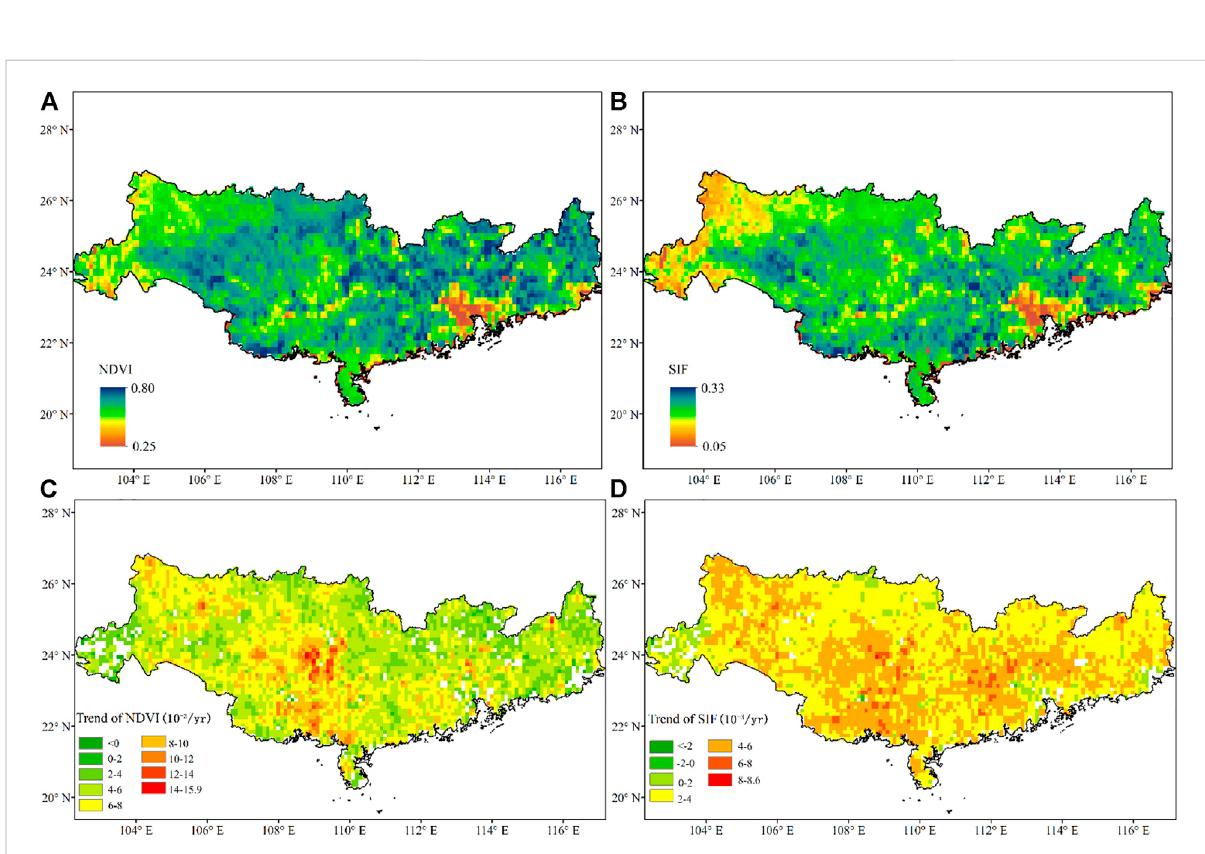
FIGURE 3 Spatial distributions of annual mean (A) NDVI and (B) SIF and trend in (C) NDVI and (D) SIF in the PRB from 2001 to 2019.